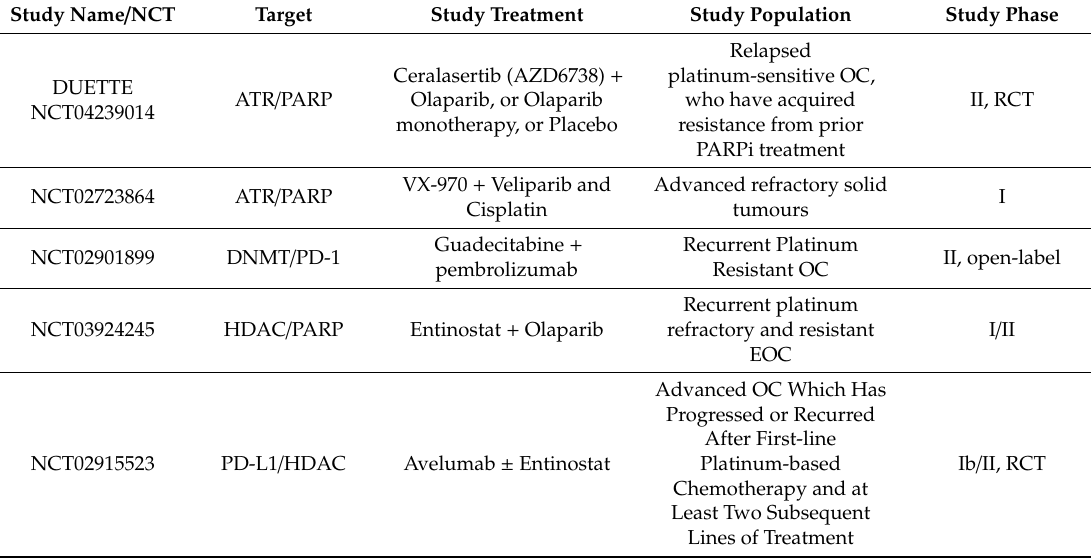
Table 1. Examples of current active trials that target DNA Damage Repair pathways to overcome resistance to PARPi and